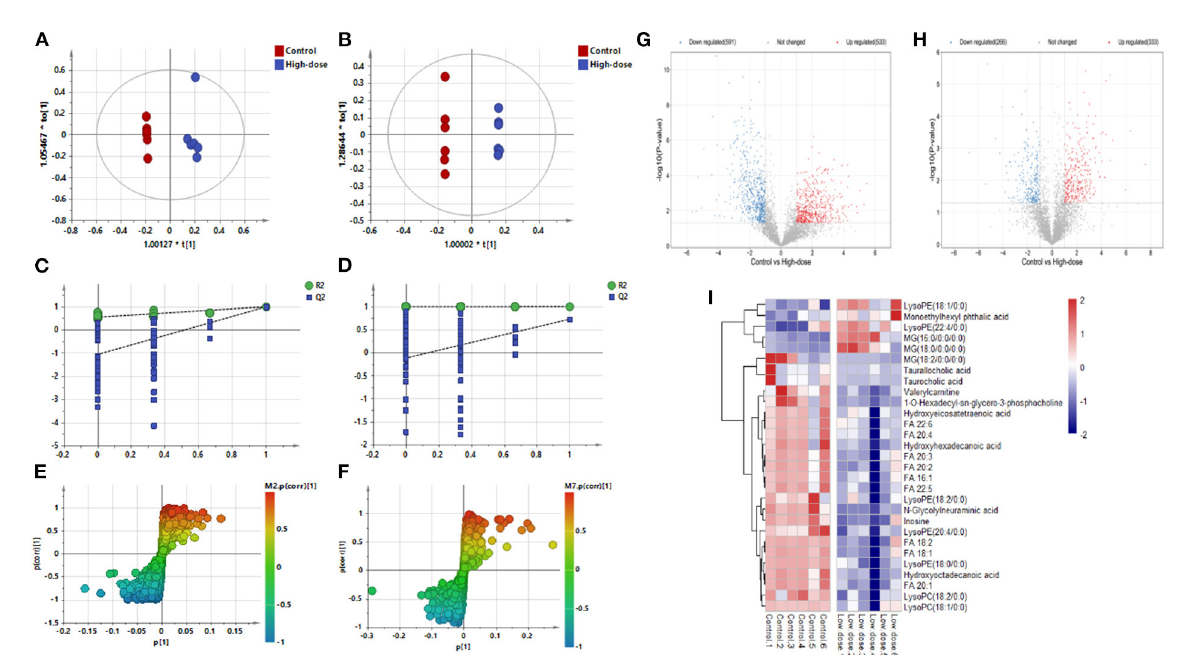
FIGURE3 OPLS-DA: Control vs. High-dose. (A) Negative ions (R 2 X 0.652, R 2 Y 0.989, Q 2 0.898), (B) Positive ions (R 2 X 0.787, R 2 Y 1.000, Q 2 0.730), (C) Negative ion replacement test, (D) Positive ion replacement tests, (E) Negative ion S-plot, (F) Positive ion S-plot. (G,H) Volcano diagram. (G) Negative ions, (H) Positive ions. ‹ Fold change (M/C) > 2 or < 0.5, and › P < 0.05 was the effective variable. Blue means down, red means up. (I) Control vs. High-dose differential metabolite heat map. The darker the red, the higher the response, and the darker the blue, the lower